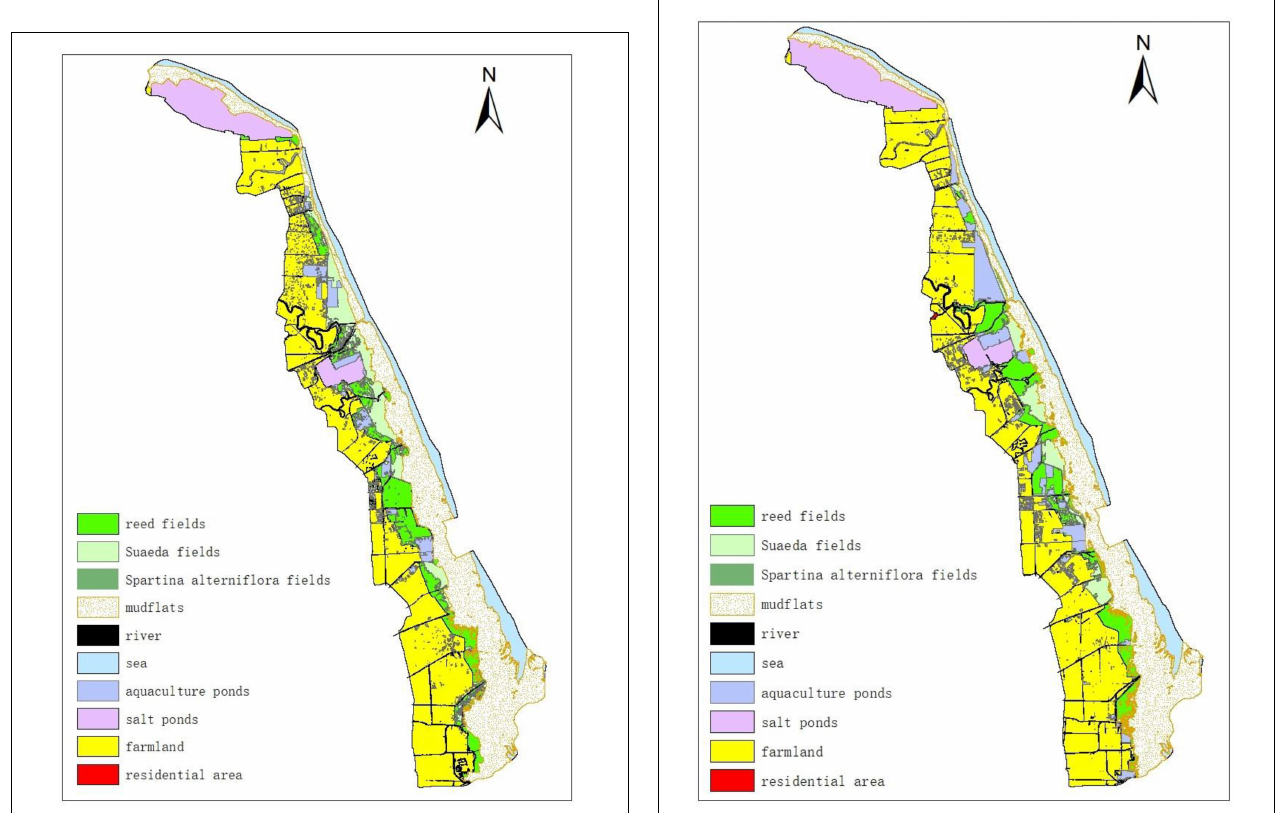
FIGURE 2 | Landscape map of Yancheng coast in 1984. FIGURE 3 | Landscape map of Yancheng coast in